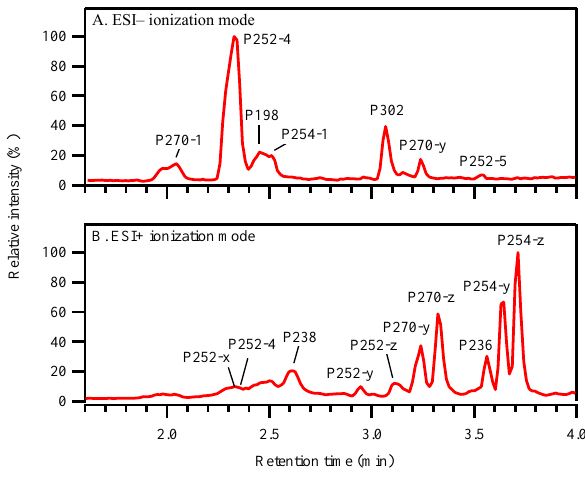
Fig. 2. Chromatograms of the particle-phase products of the dark ozonolysis of β -caryophyllene, as obtained by UPLC-ToF-MS with electrospray ionization (ESI). Ordinate values are the sum of mea- sured ion intensities. Panels (A) and (B) show the results from anal- ysis in ESI − and ESI+ modes, respectively. Product labels are as described in the caption of Fig. 1. Labels such as “P252- x ”, “P252- y ”, and “P252- z ” have ambiguous molecular assignments, with x , y , and z representing a permutation of 1, 2, and